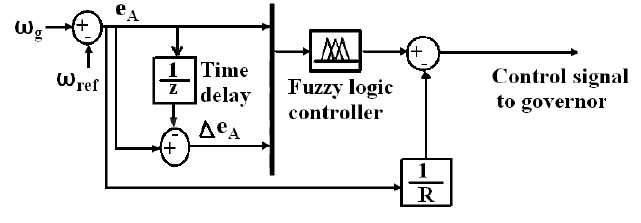
Figure 2. Governor control scheme.